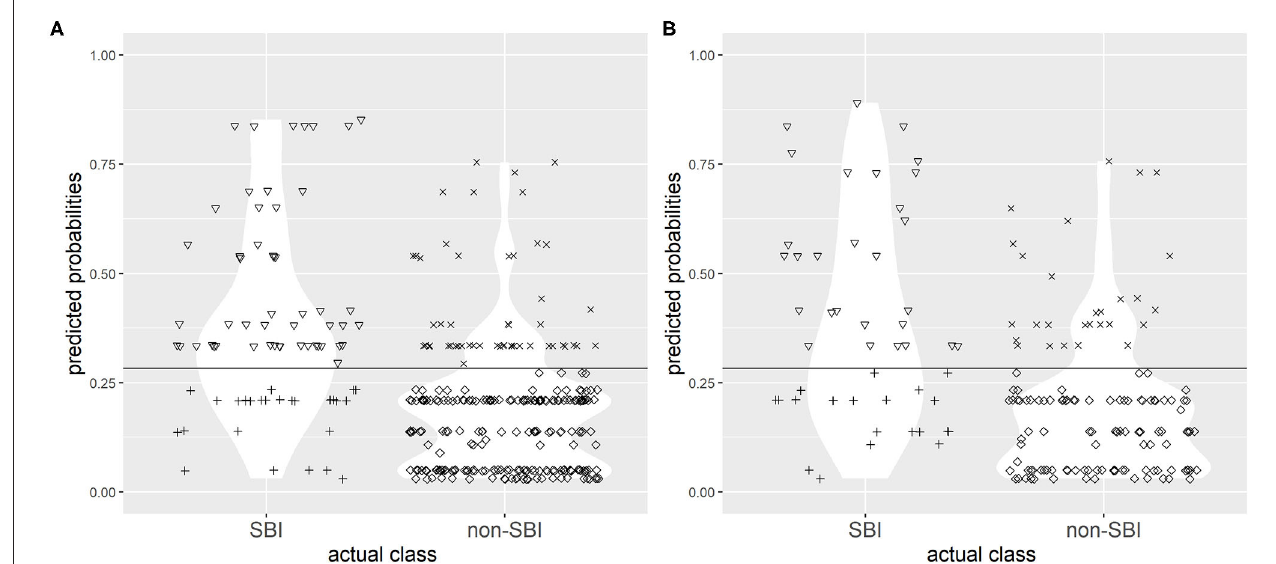
FIGURE 4 | Confusion matrix for discrimination between subjects with SBI and without SBI by clinical prediction model 2 (CPM 2) in research (A) and validation (B) populations with the chosen cut-off value of 0.283. Symbols: ▽ true positives; + false negatives; x false positives; ♦ true negatives. The horizontal line represents the cut-off